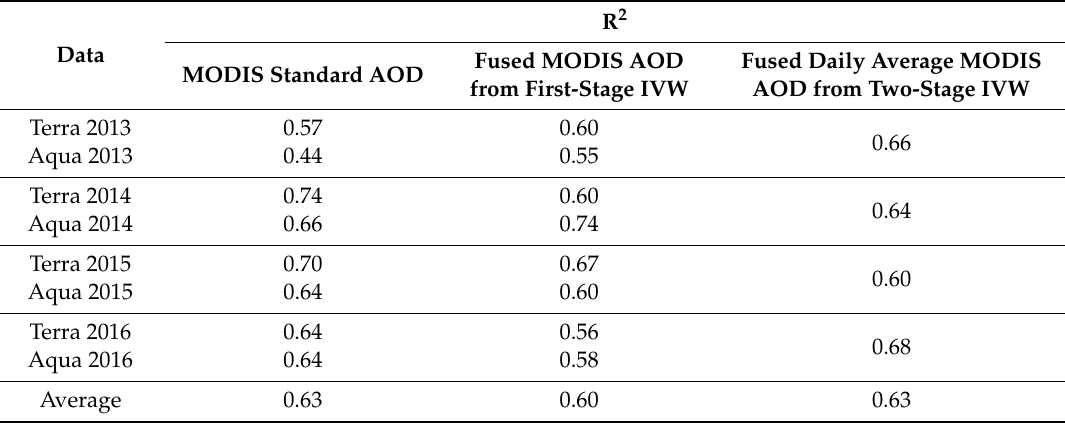
Table 2. The comparison in R 2 among MODIS standard AOD, fused AOD from first-stage IVW and fused daily average MODIS AOD from two-stage